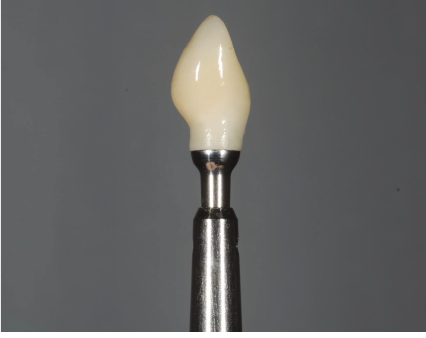
Figure 24: Aspect of the implant crown after extraoral cementation.